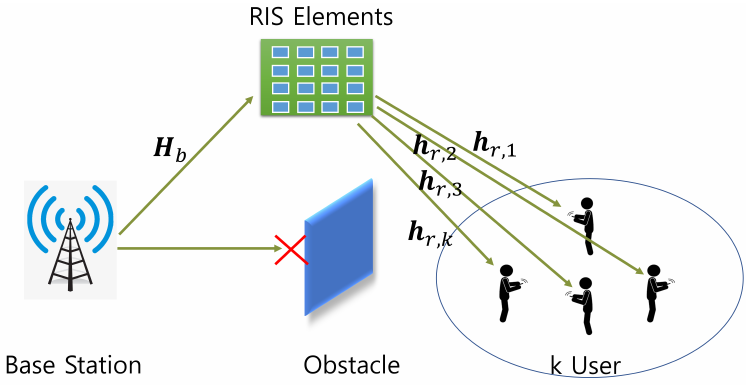
Figure 1. RIS working scenario for wireless communication system